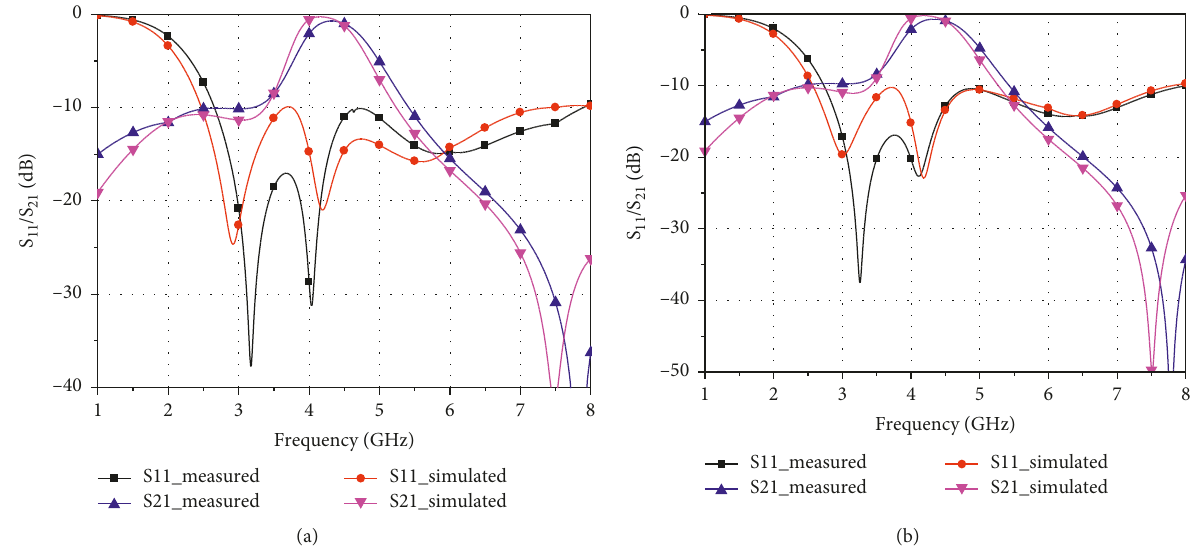
Figure 11: Measurement and simulated results under the normal incidence. (a) TE polarization. (b) TM polarization. Table 1: Performance